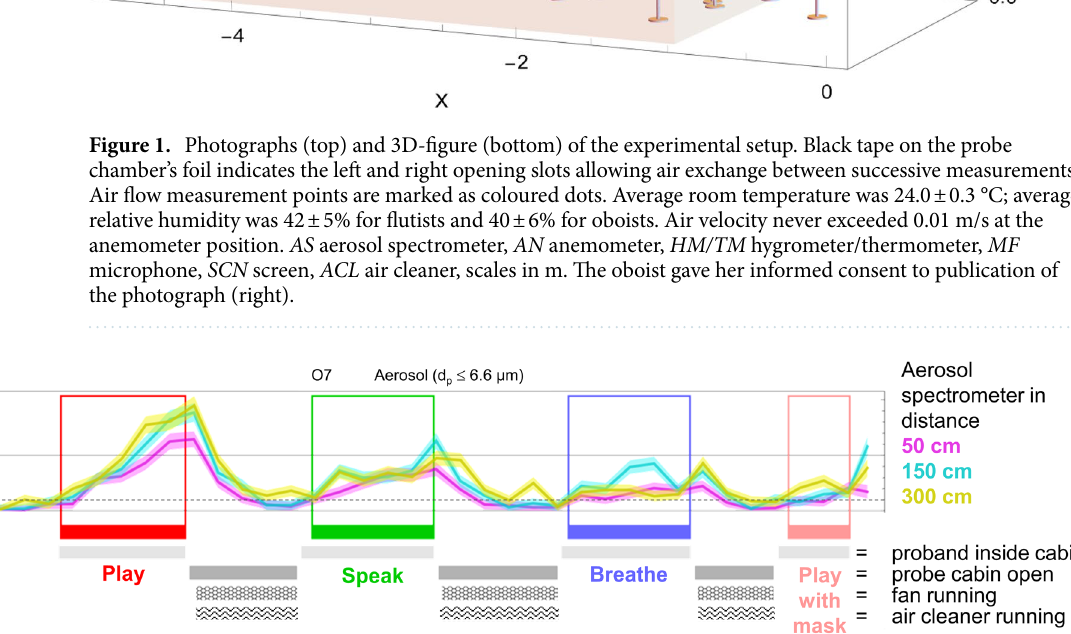
Figure 2. Temporal evolution of the particle air concentration during the measurement session with oboist no. 7. Solid lines indicate maximum likelihood values and shaded regions visualize the estimation uncertainty. Line colors indicate the aerosol spectrometer position and box colors indicate the task performed. The dashed line indicates the background concentration of particles inside our measurement tent as guide to the eye. Baseline values were reconditioned after each task by opening the probe chamber and flooding it with fresh air from the surrounding operating theatre. The airing was accelerated using a fan and an air cleaner (indicated by pattern bars below the